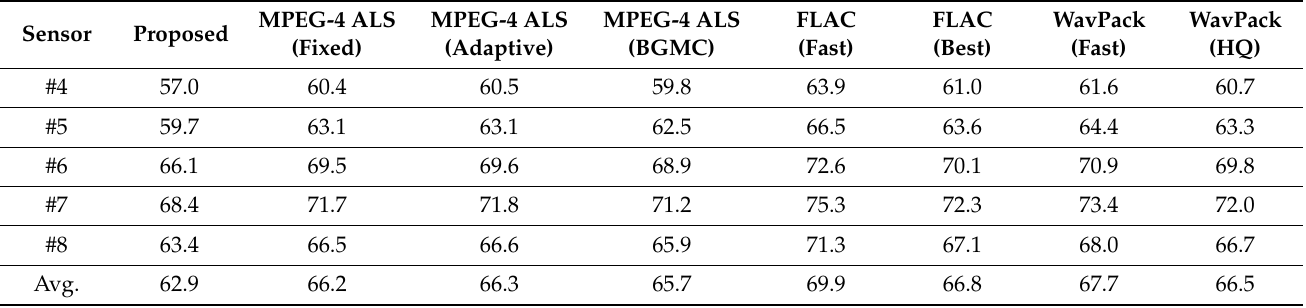
Table 3. Comparison of the compression ratios (%) between the proposed method and other standard compression